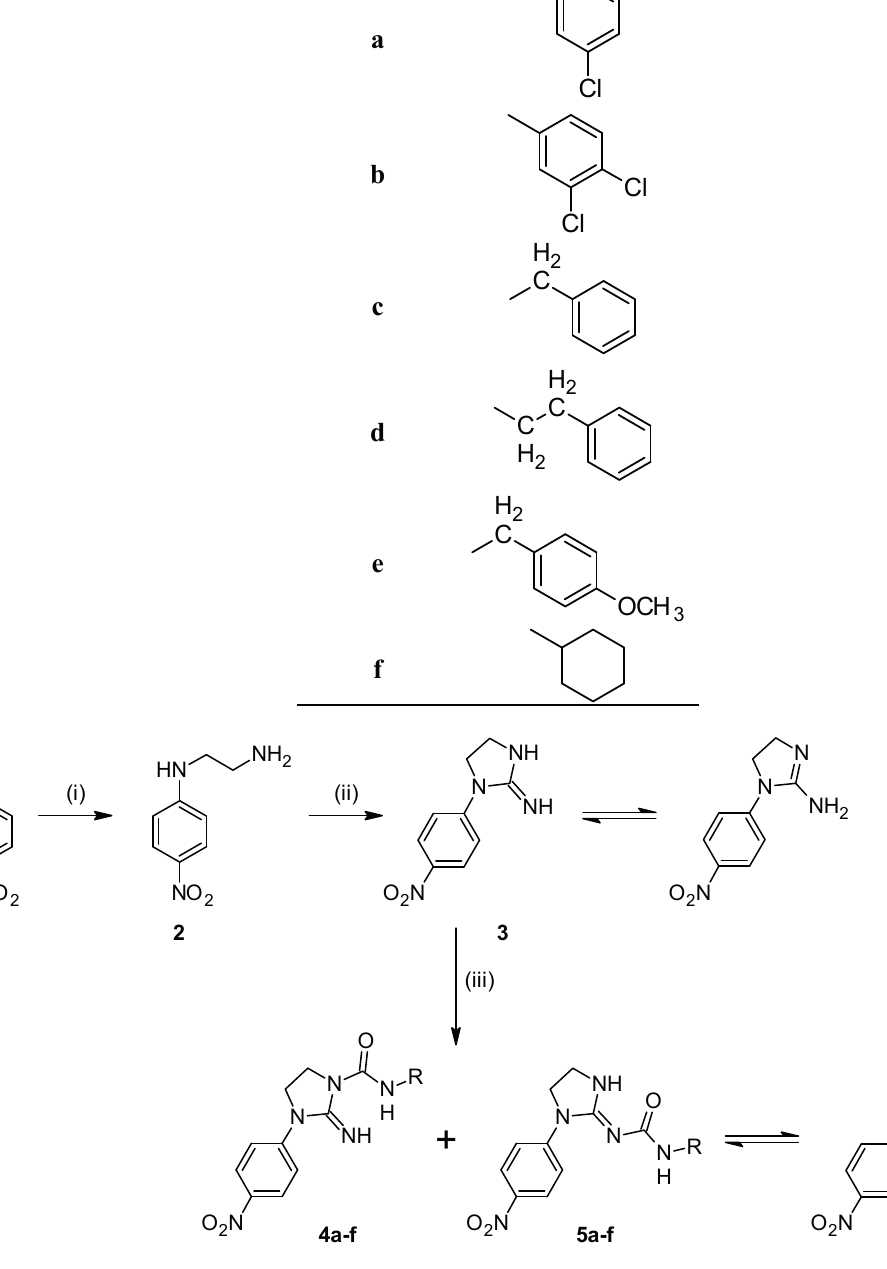
Table 1. Isocyanates and substituents in target